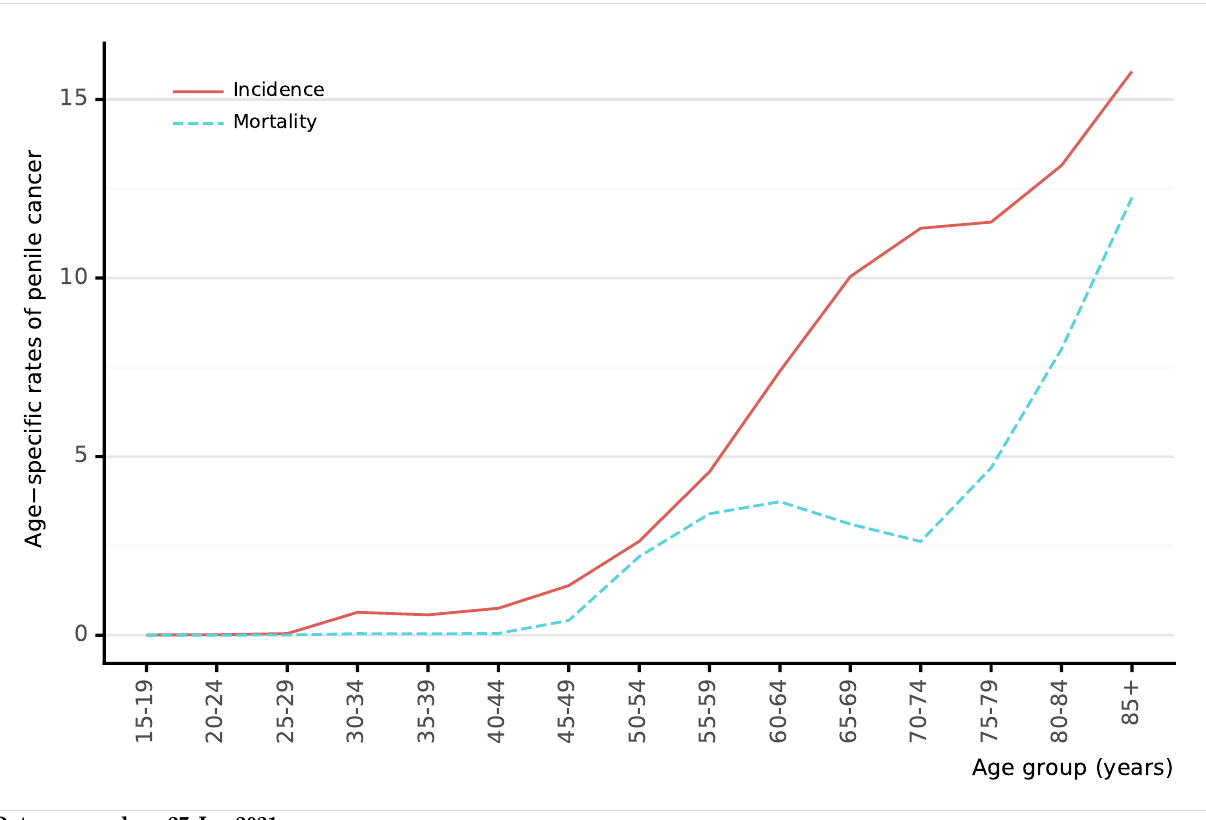
Figure 35: Comparison of age-specific penile cancer incidence and mortality rates in India